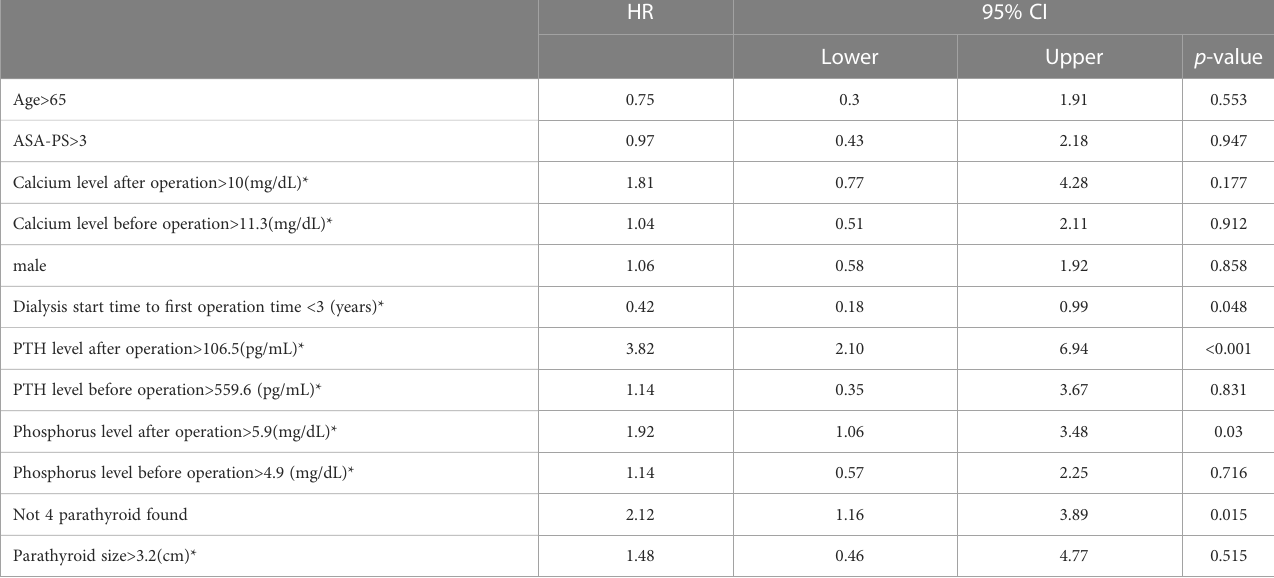
TABLE 2 Univariate analysis of risk